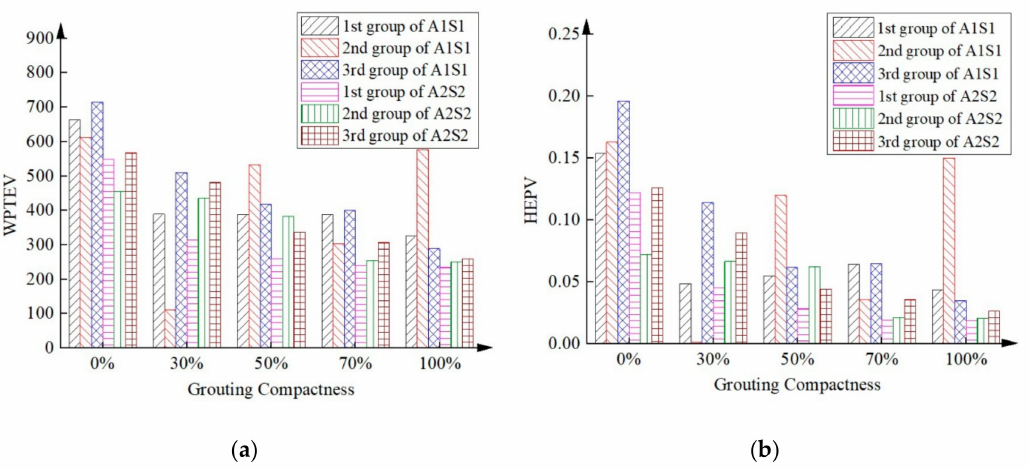
Figure 8. Relationship between the grouting compactness and the proposed indices: ( a ) wavelet packet energy (WPE) method, ( b ) Hilbert–Huang transform (HHT)